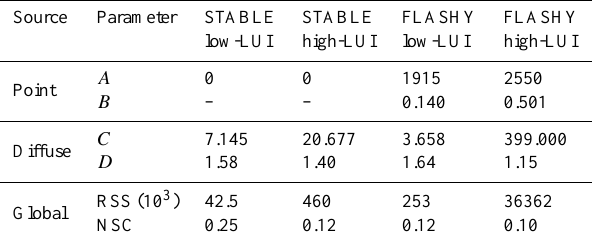
Table 4. Estimated parameters for the load apportionment model fitted for each stream. RSS: residual sum of squares. NSC: Nash– Sutcliffe model efficiency coefficient. STABLE: low-flashiness Danish streams; FLASHY: Uruguayan flashy streams; low- and high-LUI: low and high land use